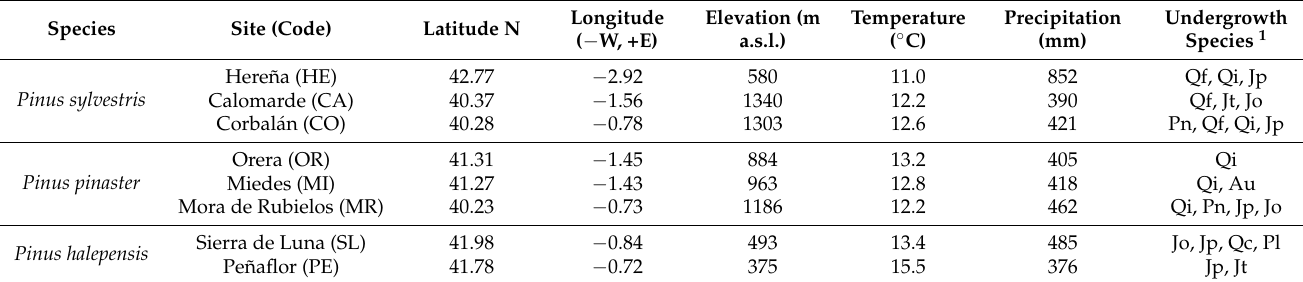
Table 1. Characteristics of the study sites. Climate data correspond to the 1970–2020 period. Species Site